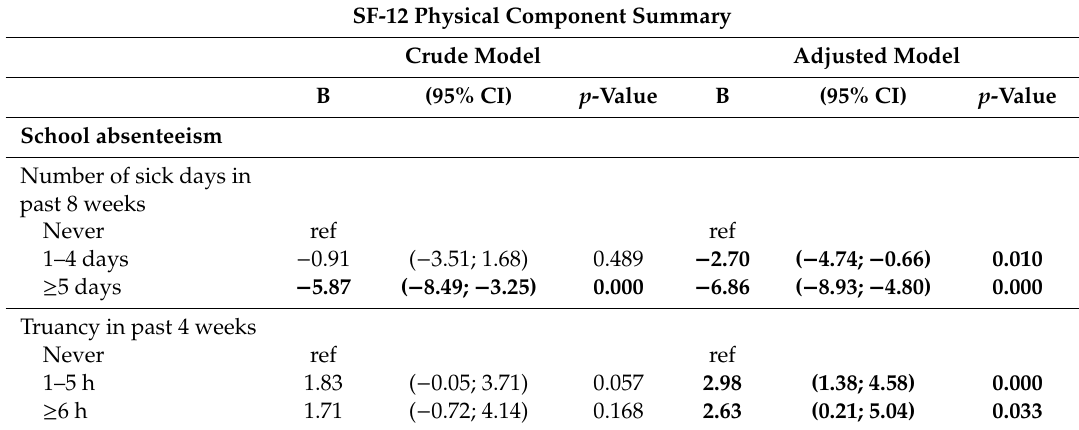
Table 3. Results from the multivariable general linear models evaluating the association of school absenteeism with physical HRQOL.